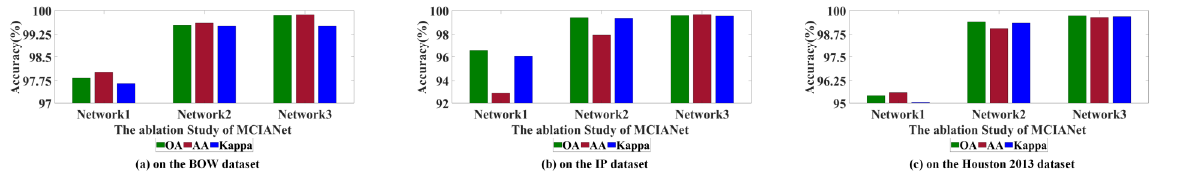
Figure 14. The ablation study of proposed MCIANet.